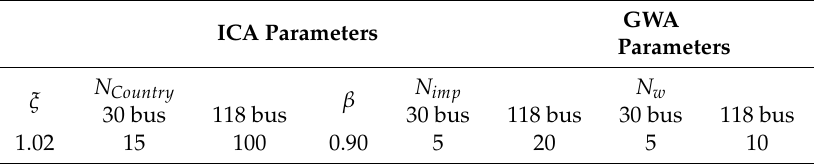
Table 2. Setting of the proposed HIC-GWA approach.